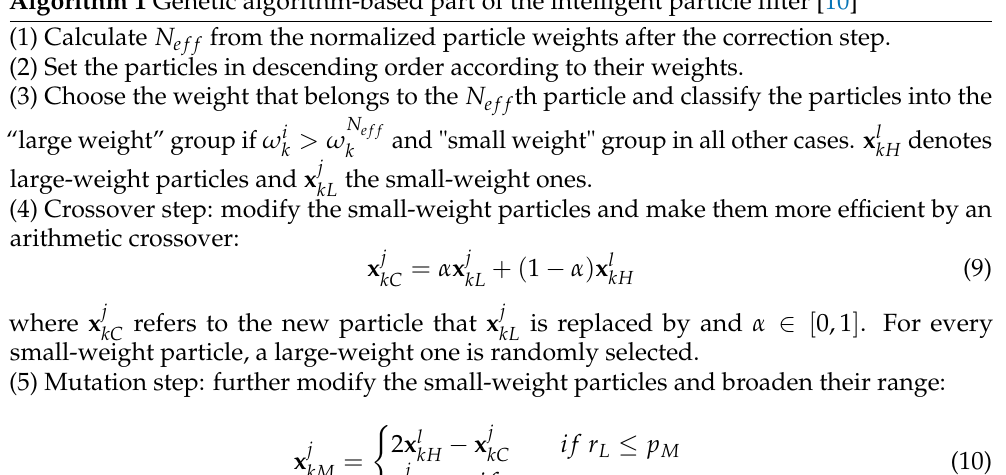
Algorithm 1 Genetic algorithm-based part of the intelligent particle filter [10]